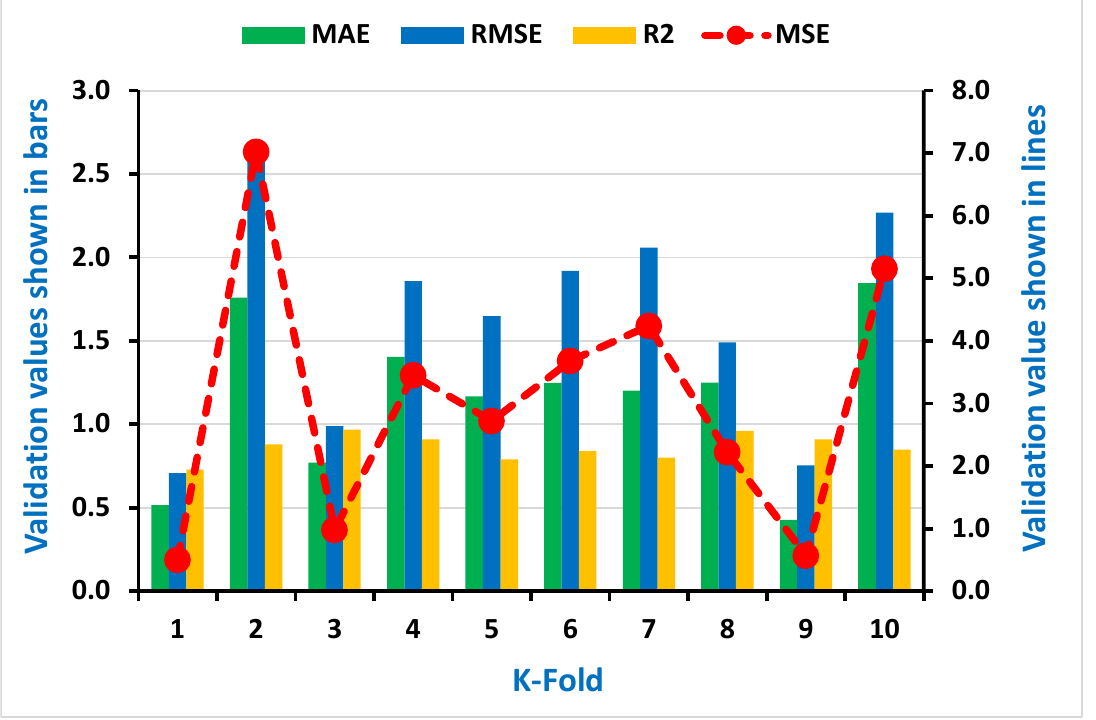
Figure 8. Representation of statistical information of k-fold cross-validation using DT for splitting tensile strength.